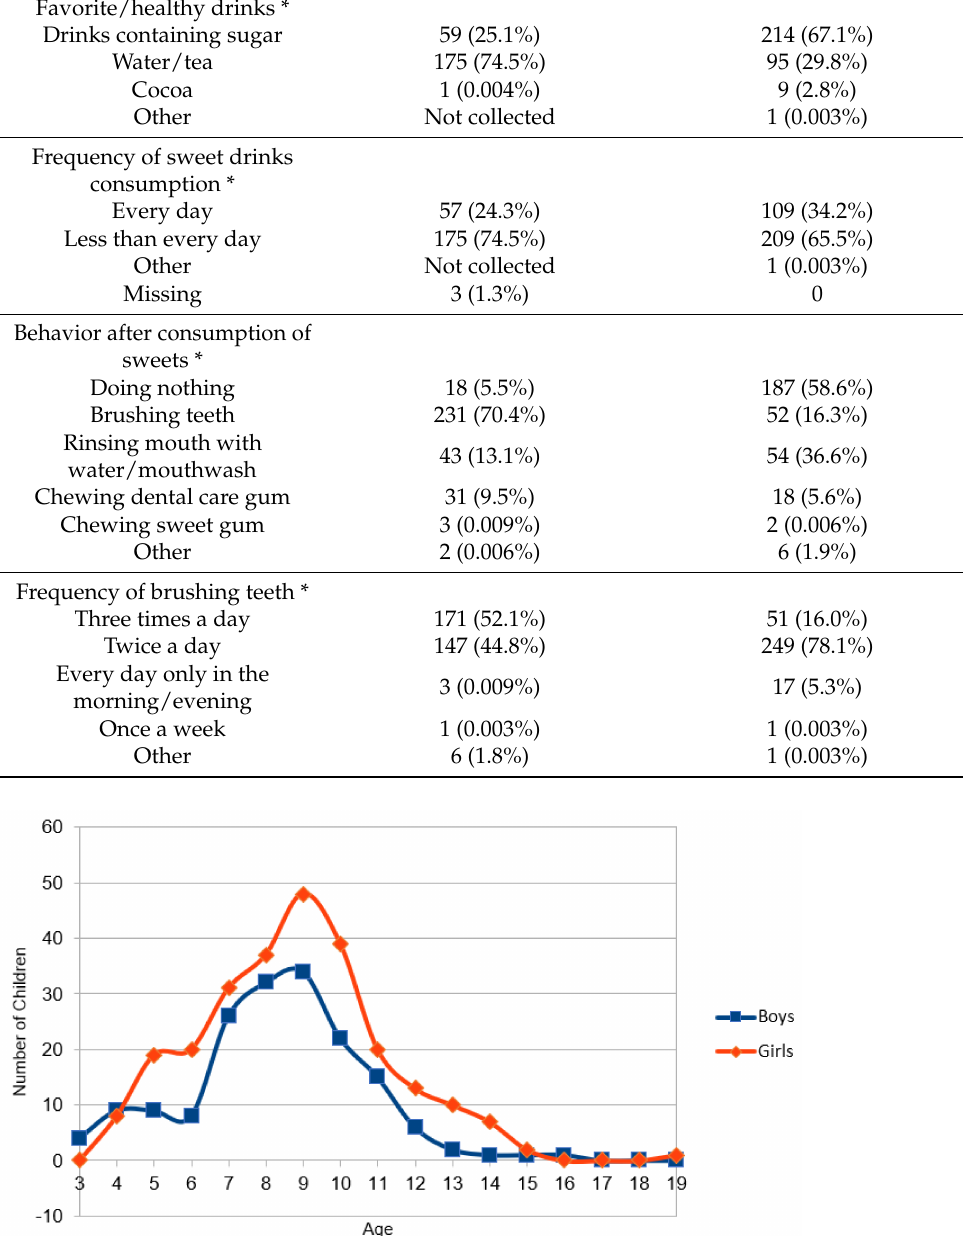
Figure 1. Age and gender distribution across all years (2016, 2017,